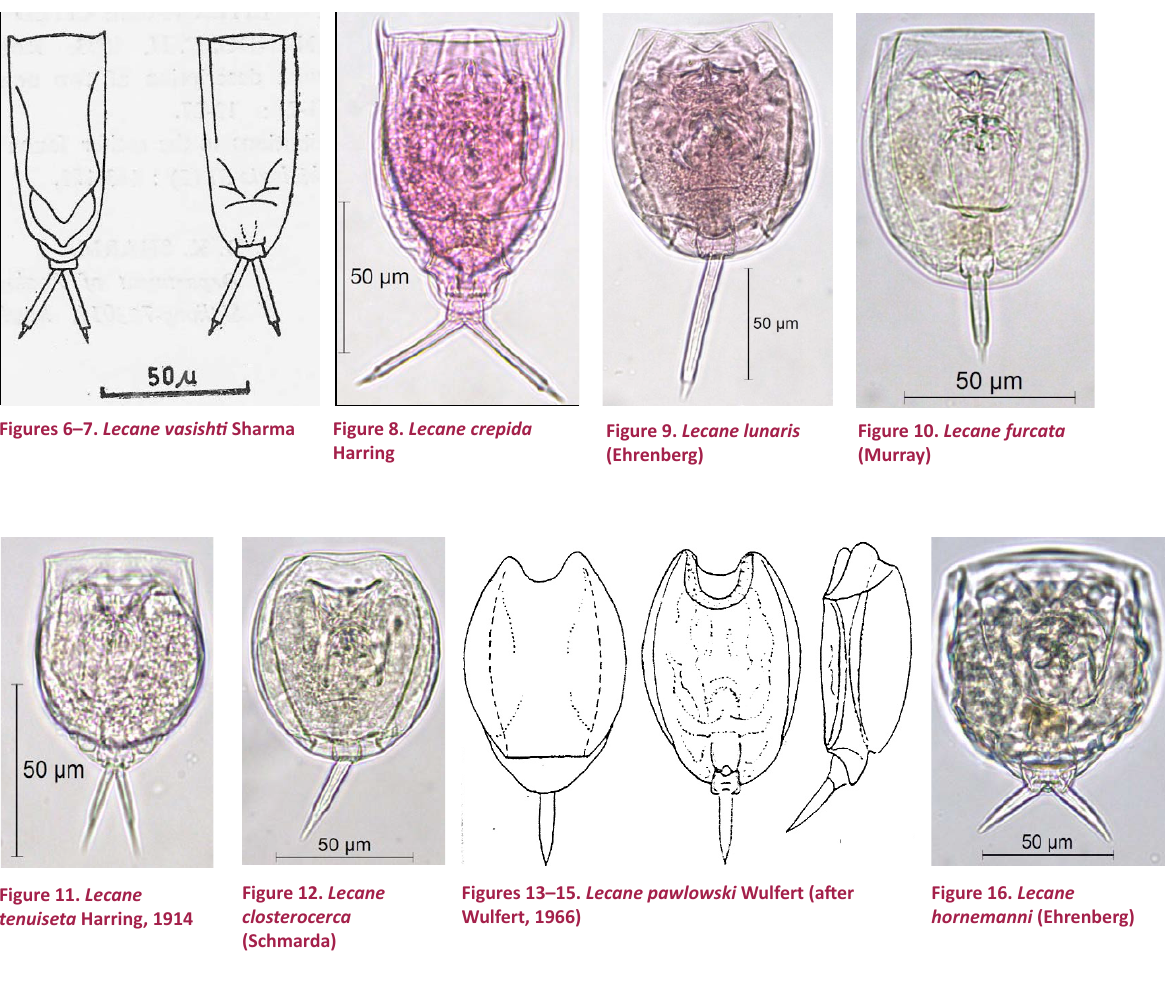
Figure 16. Lecane hornemanni